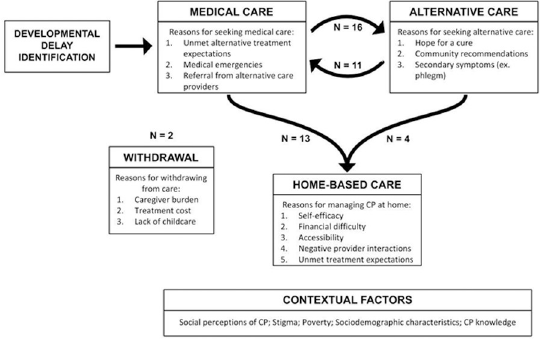
Fig 1. Key care-seeking factors for children with cerebral palsy (CP), N = 25. Common care-seeking transitions with rationales as reported by caregivers and providers. N values reflect the number of caregiver participants who made each transition and are not generalizable beyond this study